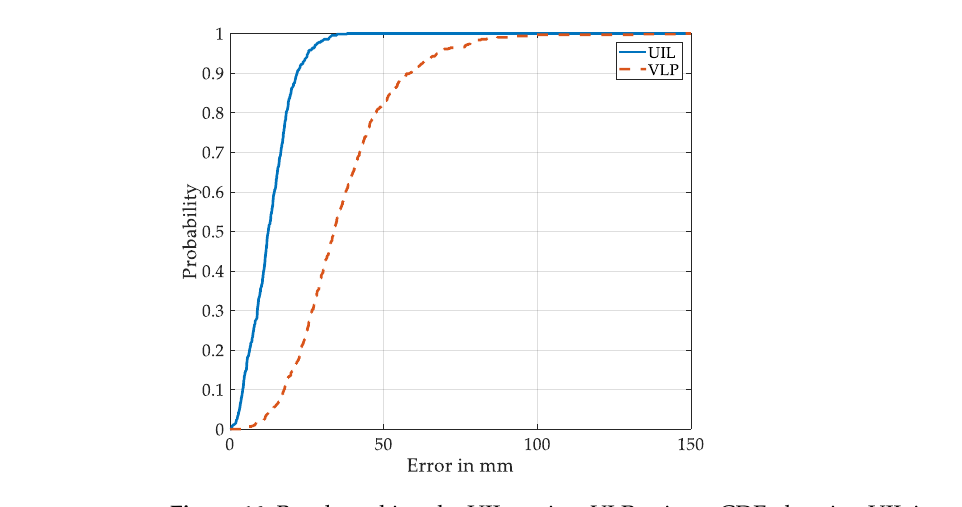
Figure 16. Benchmarking the UIL against VLP using a CDF, showing UIL is more accurate. Mean, median, 90 th percentile and standard deviation of the error shown in Table 3.